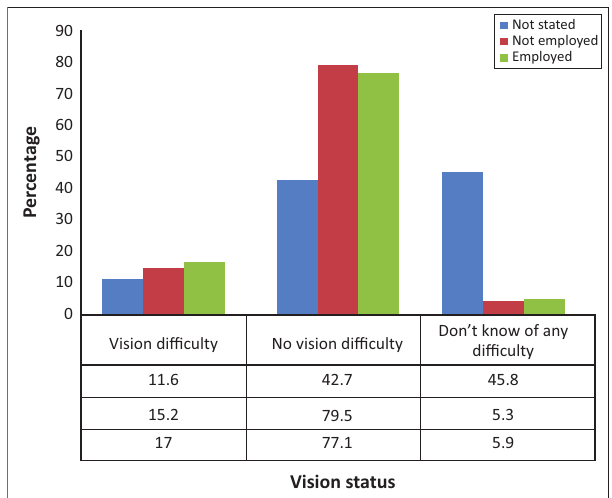
FIGURE 1: Employment and vision status.